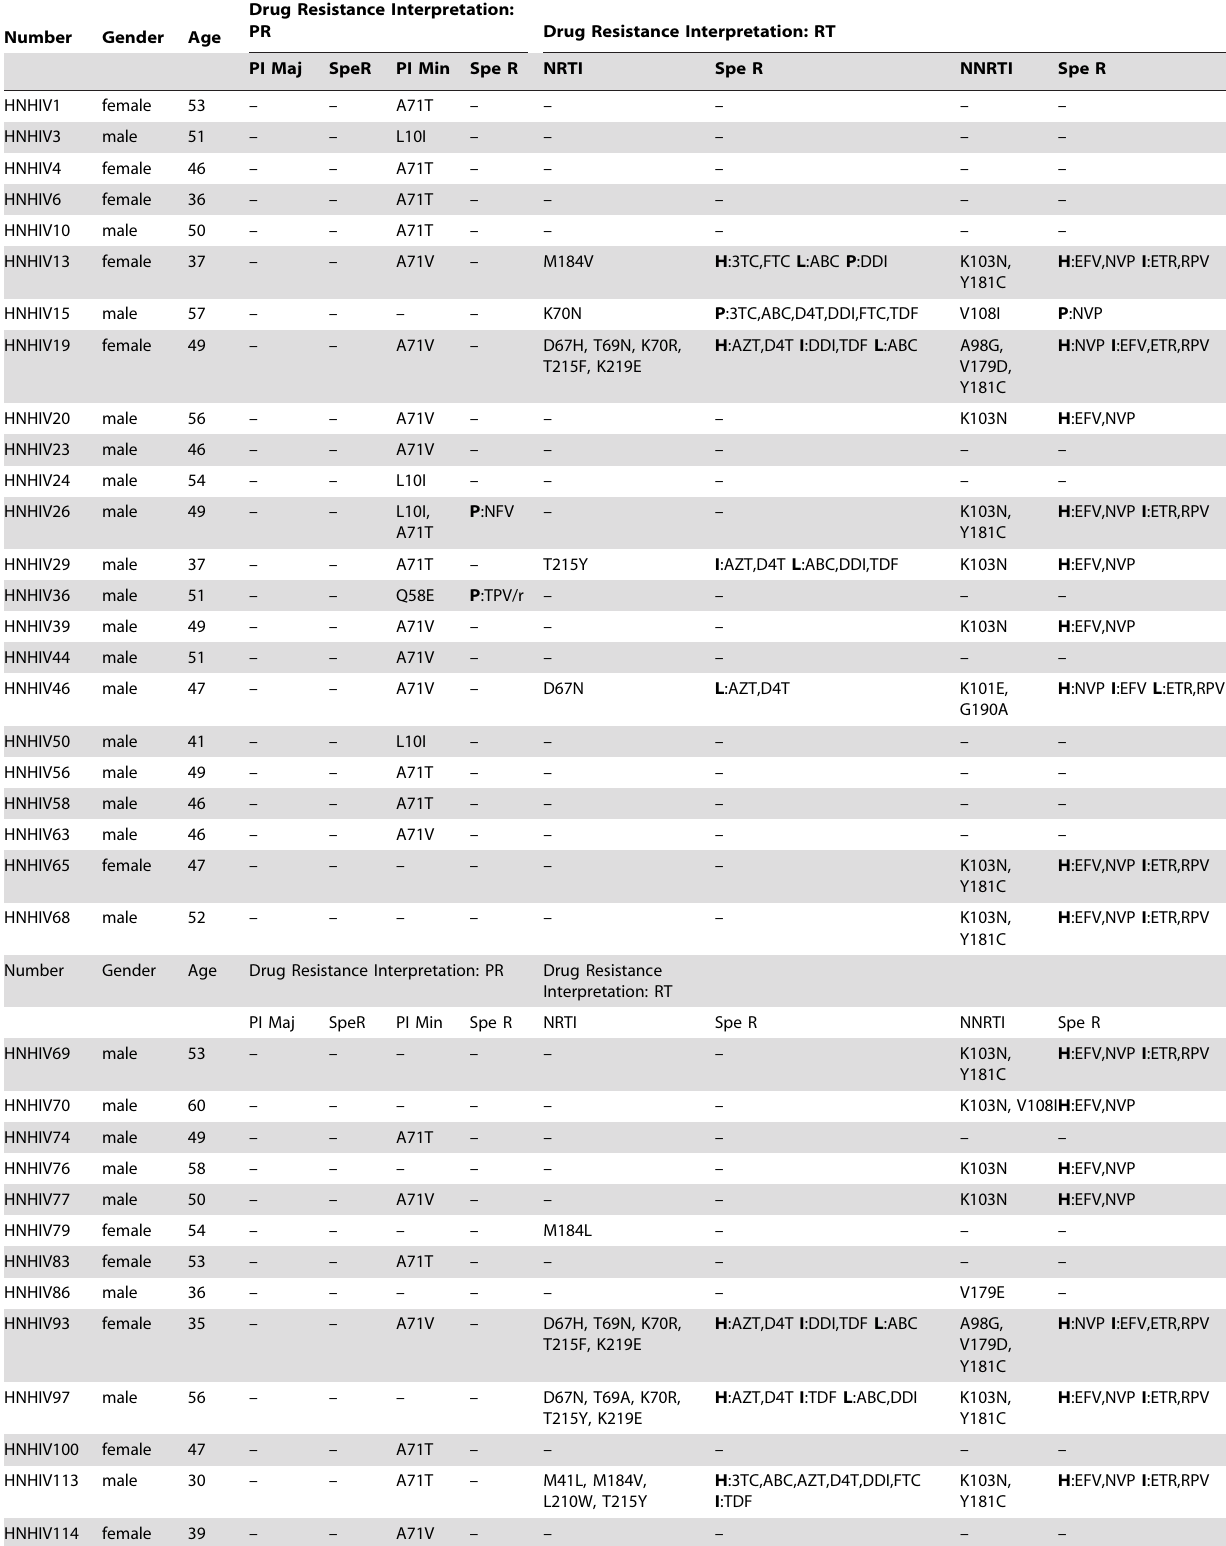
Table 3. HIV-1 drug resistance mutations natural distribution of former paid blood donation population in Henan